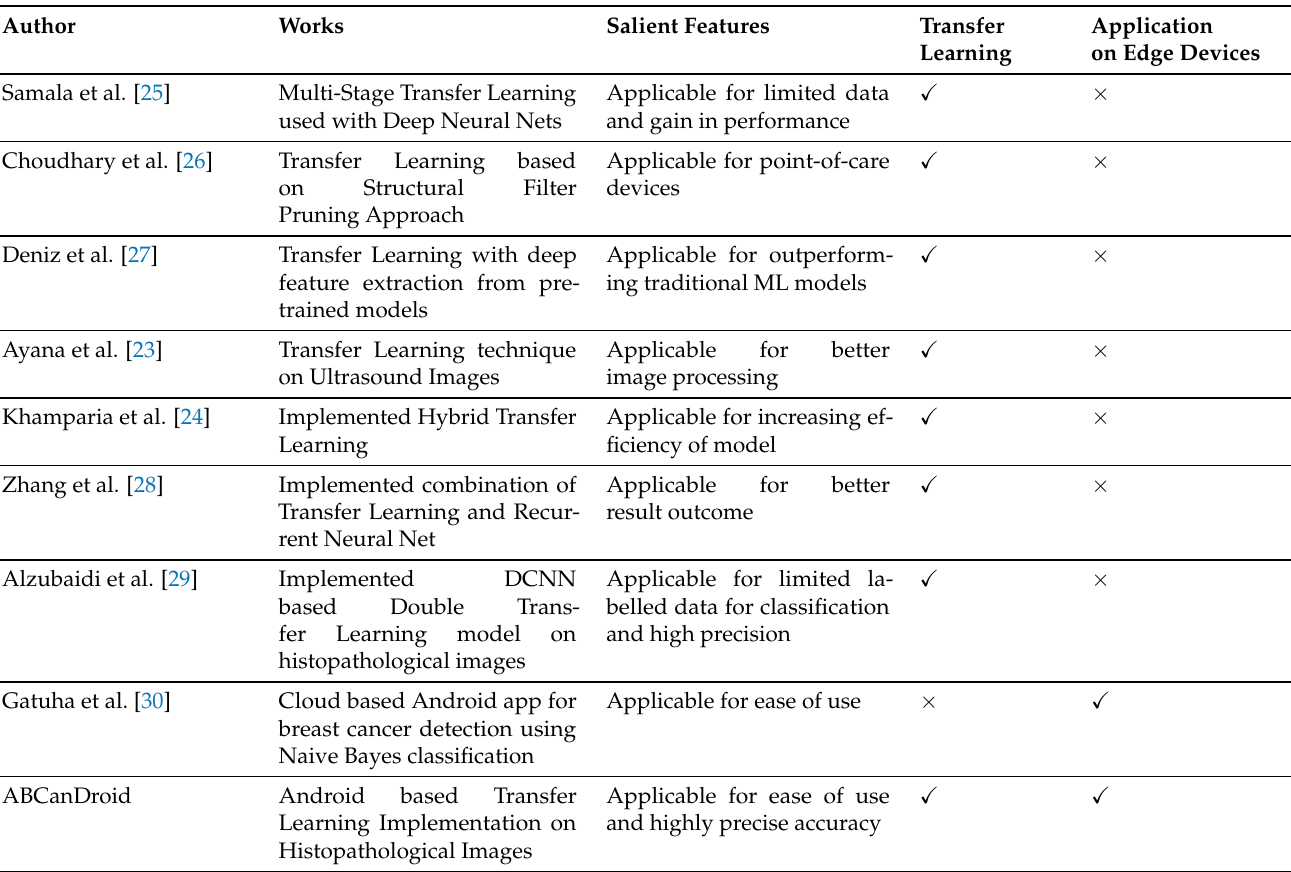
Table 1. Comparative study of related works for breast cancer